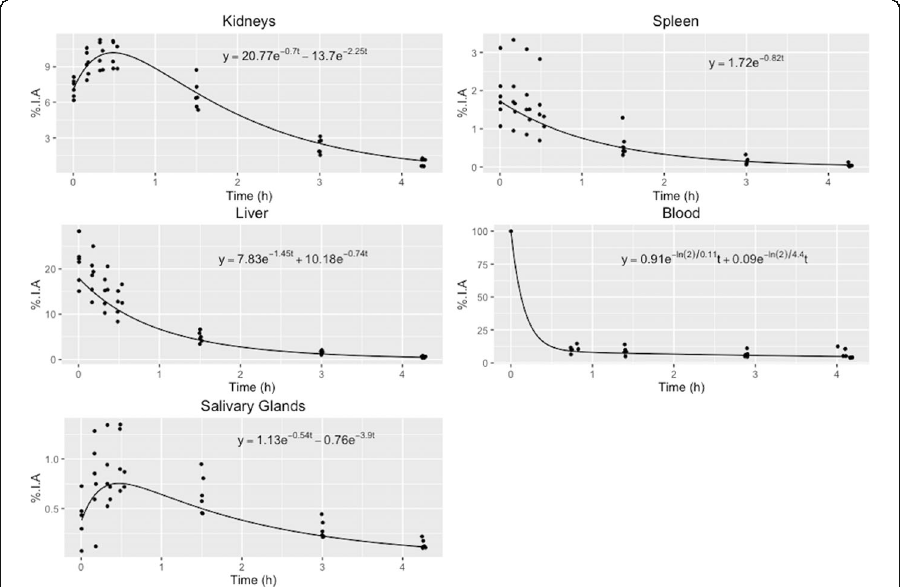
Fig. 4 Injected activity. The median activity concentration of the six participants expressed in percent injected activity (%IA) for a selection of organs. The fitted bi-exponential or mono-exponential functions used can be seen in each